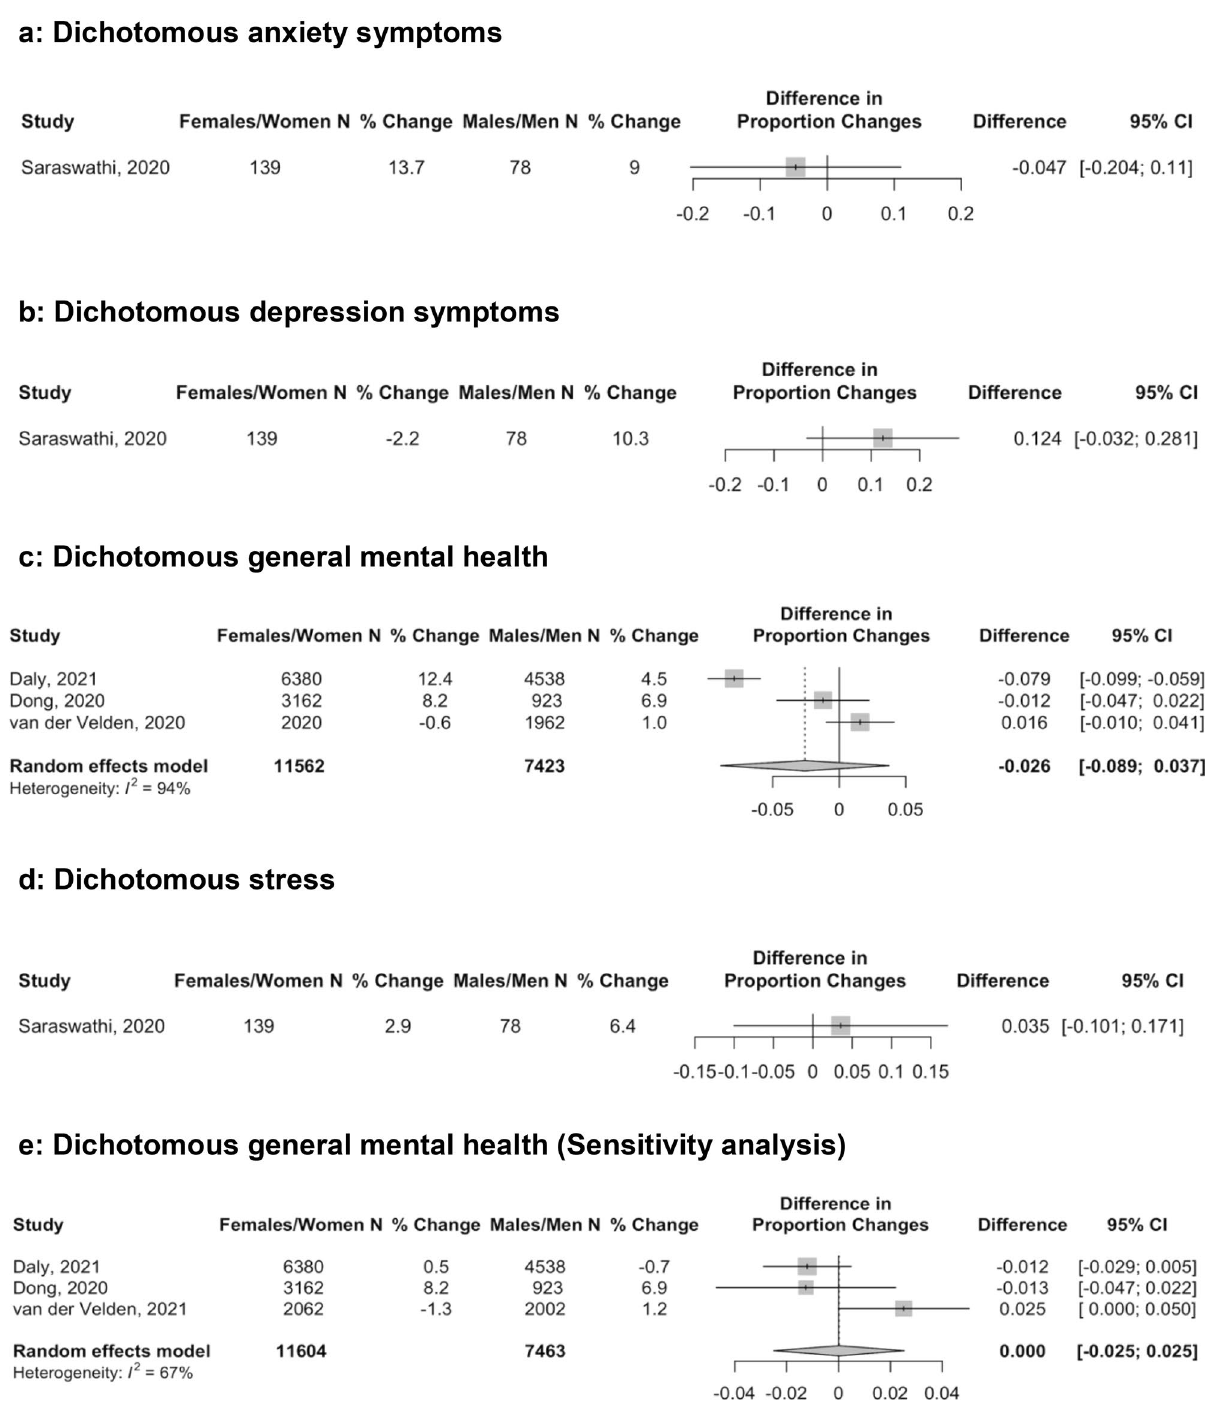
Figure 2. Forest plots of standardized mean difference of the difference in change in proportion above a cut-off for anxiety ( a ), depression ( b ), general mental health ( c ), and stress ( d ) between females or women and males or men. Positive numbers indicate greater negative change in mental health in females or women compared to males or men. ( c ) reflects dichotomous COVID-19 mental health measured in early 2020, whereas ( e ) reflects measurements from late 2020 for Daly 50 and van der Velden 52